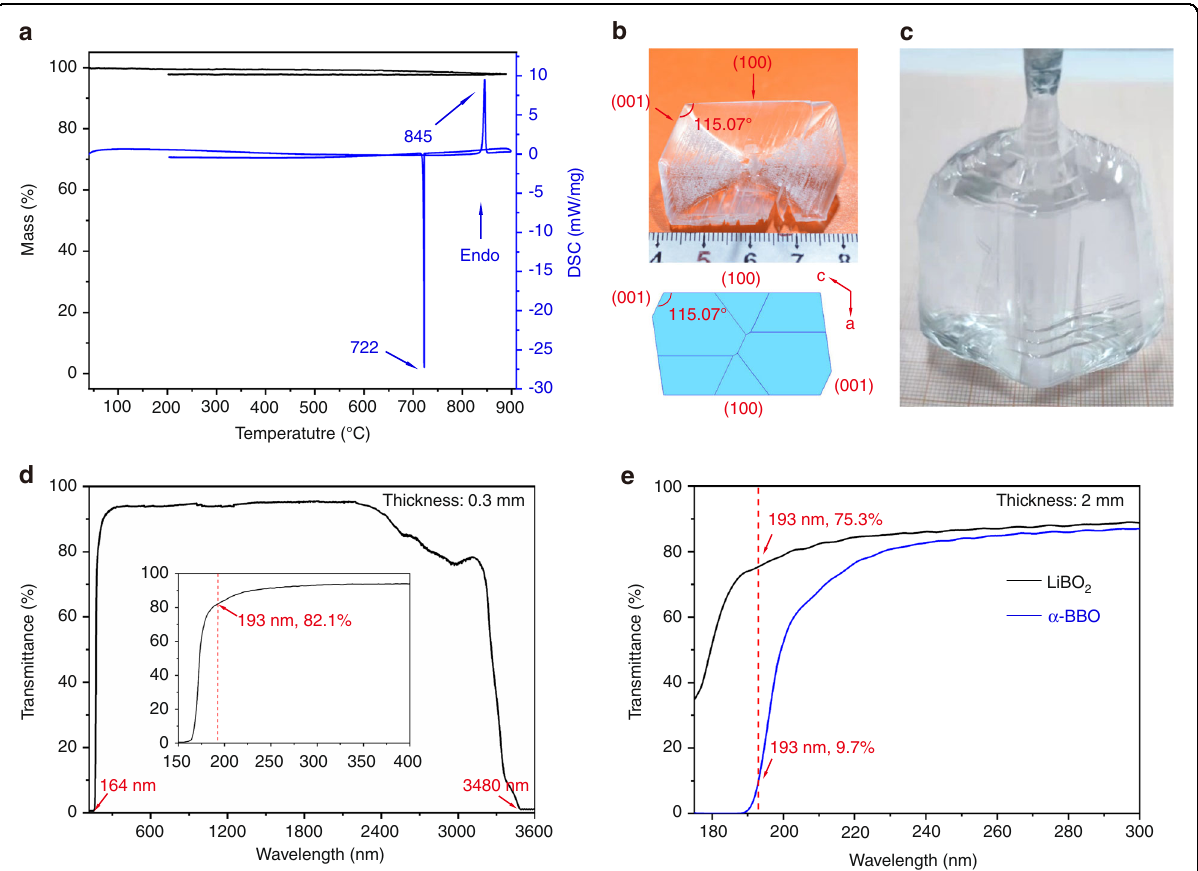
Fig. 1 Thermal property, as-grown single crystals, and transmittance spectra of LiBO 2 . a TG-DSC curves of LiBO 2 . b As-grown LiBO 2 crystal via top-seeded growth method from the stoichiometric melt (top) and the theoretical morphology viewed along b -axis (bottom). c As-grown LiBO 2 crystal via the Czochralski method using [010]-oriented seed. d Transmission spectra of LiBO 2 . e Comparison of transmission spectra of LiBO 2 and α -